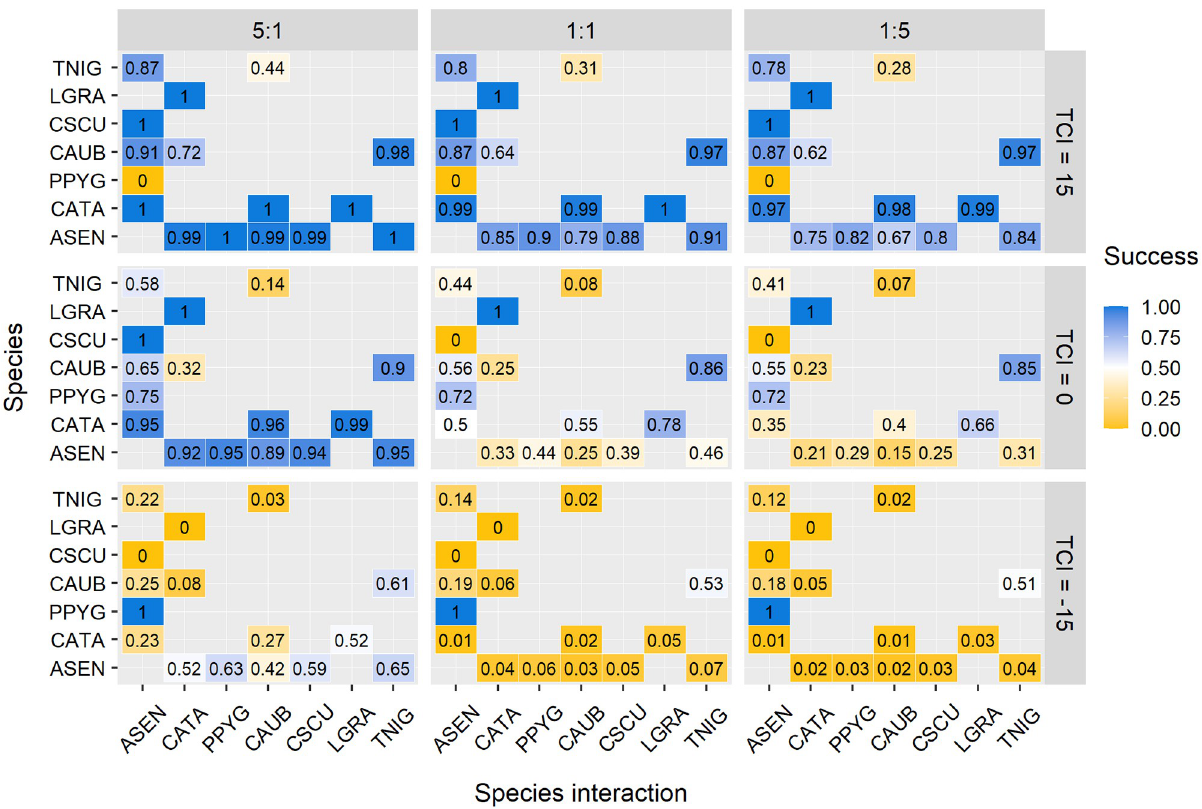
Fig 6. Pairwise comparisons showing the probability of success for the most common species-species interaction at three levels of worker proportion (5:1, 1:1, 1:5) and three levels of the thermal competition index (15, 0, -15). The values express the probability of success for the x axis species. Color gradient represents the probability of success in the competitive interaction: orange indicates lower probability, while blue indicates higher probability. Numbers in each box indicate the probability. Squares separate the species’ interactions into subordinate-subordinate (bottom-left), dominant-subordinate (top-left and bottom-right) and dominant-dominant (top-right). Species abbreviations: Subordinates: ASEN ( Aphaenogaster senilis ), CATA ( Cataglyphis floricola and Cataglyphis tartessica ) and PPYG ( Plagiolepis pygmaea ); Dominants: CAUB ( Crematogaster auberti ), CSCU ( Crematogaster scutellaris ), LGRA ( Lasius grandis ) and TNIG ( Tapinoma cf. nigerrimum